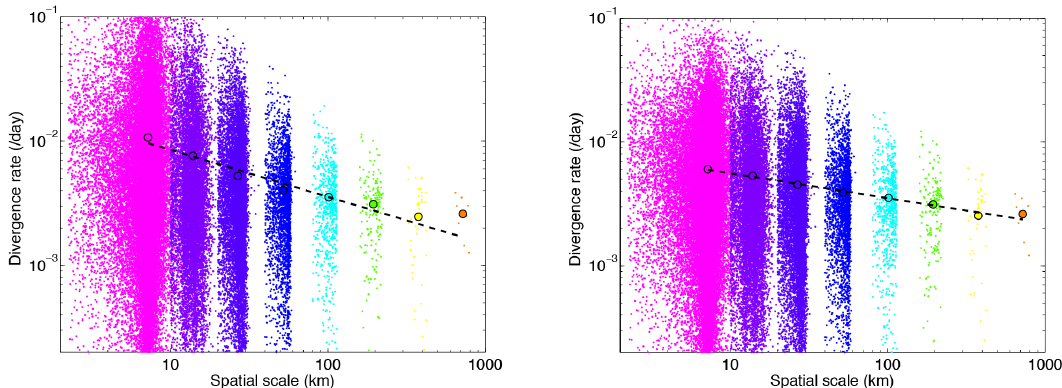
Figure 10. Scaling analysis: absolute divergence rate as a function of the spatial scale, from the unfiltered (left panel) and filtered (right panel) composite deformation field for the period 2–10 February 2007 (each color corresponds to a different box size used for the coarse graining procedure). The mean values (cid:104)|˙ (cid:15) div |(cid:105) are represented by circles, and the dashed lines are power-law fits of the first six mean values (here, from 7 to